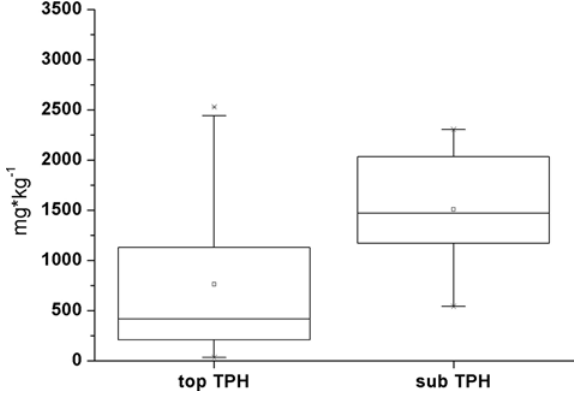
2.17c).Fig. 5. Concentration of TPH in the subsurface and in the